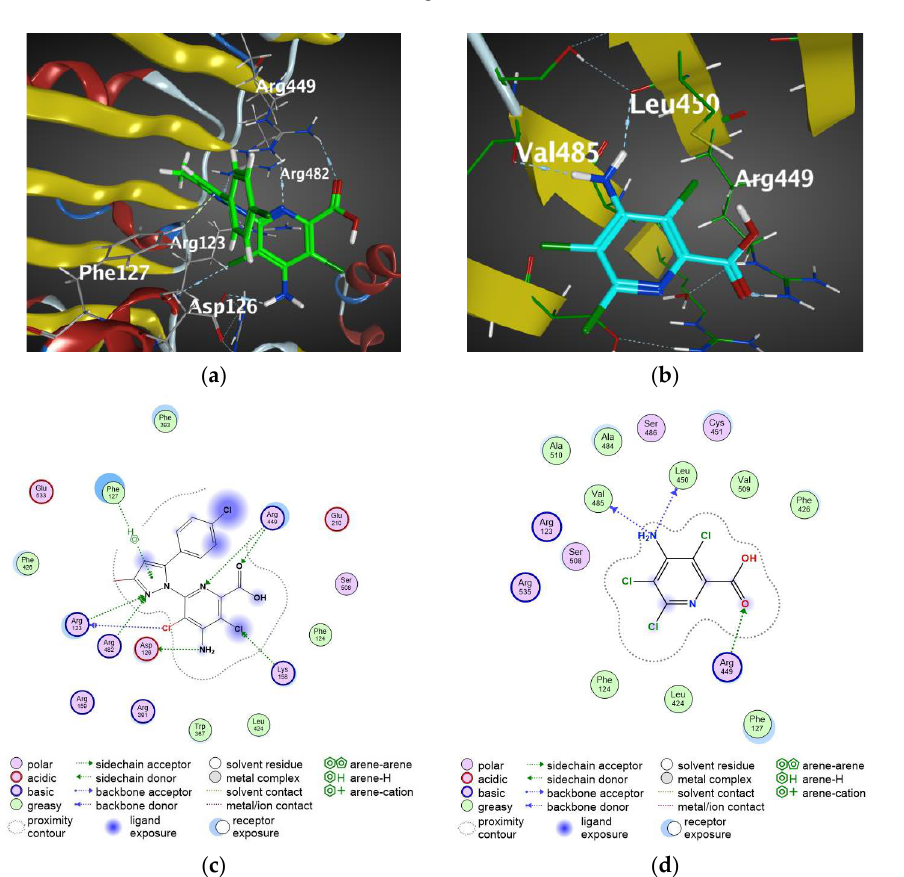
Use London dG and GBVI/WSA dG as rescoring functions. As shown in Figure 4, compound V-7 , whose binding energy was − 8.33 kJ mol −1 , ex- hibited hydrogen bonding with five amino acid residues: Arg449, Arg482, Arg123, Phe127, and Asp126, whereas picloram with a binding energy of − 6.53 kJ mol −1 exhibited hydrogen bonding with three amino acid residues: Arg449, Val485, and Leu450, which probably explained the difference of the binding energies between two molecules at a cer- tain level. In particular, the nitrogen atom at position 2 of the pyrazolyl ring in compound V-7 forms a hydrogen bond with residues Arg123 and Arg 482, which demonstrates that the proposed design improved the modification of molecules.